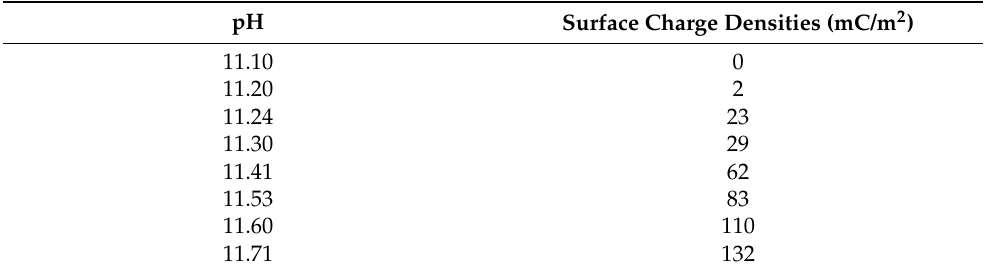
Table 11. Measured relative surface charge densities of C-S-H as a function of pH